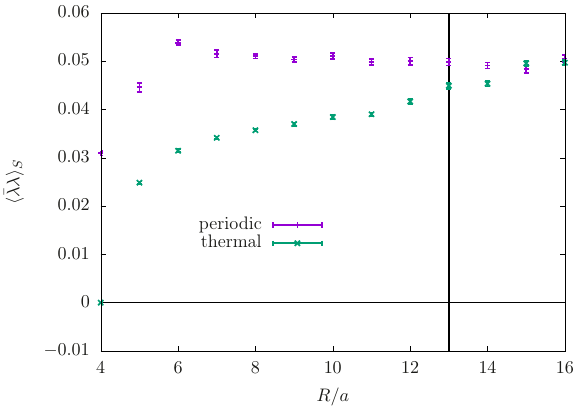
Figure 12 . Subtracted chiral condensate as a function of the compactification radius for periodic and anti-periodic boundary conditions with the same parameters as in figure 6. The black vertical line indicates the maximum of the chiral susceptibility for anti-periodic boundary conditions. Note the persistence of a non-vanishing chiral condensate when fermions are endowed with periodic boundary condition up to very small circle